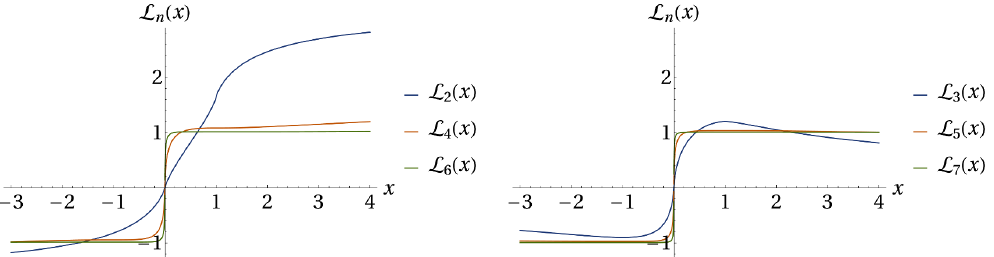
Figure 4 . Plots of the single-valued polylogarithms defined in eq. (C.6), on the left for even n , on the right for odd n